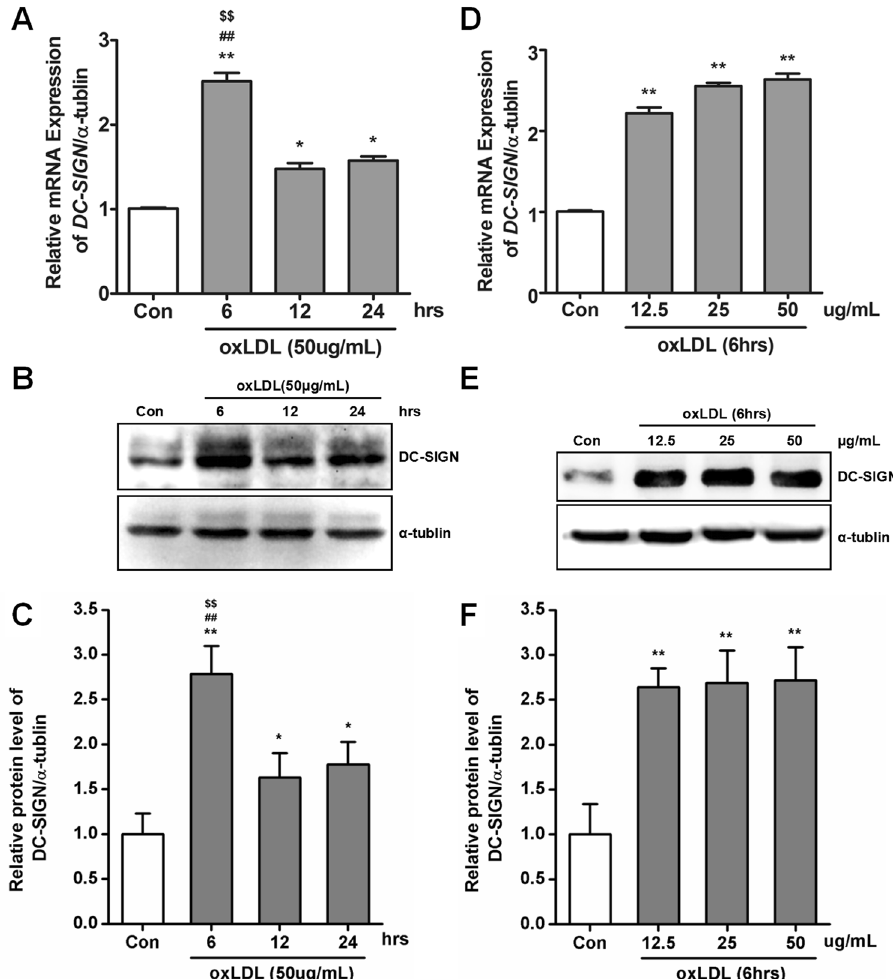
6 hours). The expression level of DC-SIGN was detected by real-time PCR ( A and D ) and western blot analysis ( B and E ) and quantified by densitometry as relative units (DC-SIGN/ α -tubulin) in 3 independent experiments ( C and F ). The data are expressed as the mean ± SD from 3 independent tests. * P < 0.05, ** P < 0.01 compared with human primary macrophages not treated with oxLDL, ## P < 0.01 compared with human primary macrophages not treated with oxLDL within 12 hours, $$ P < 0.01 compared with human primary macrophages not treated with oxLDL within 24